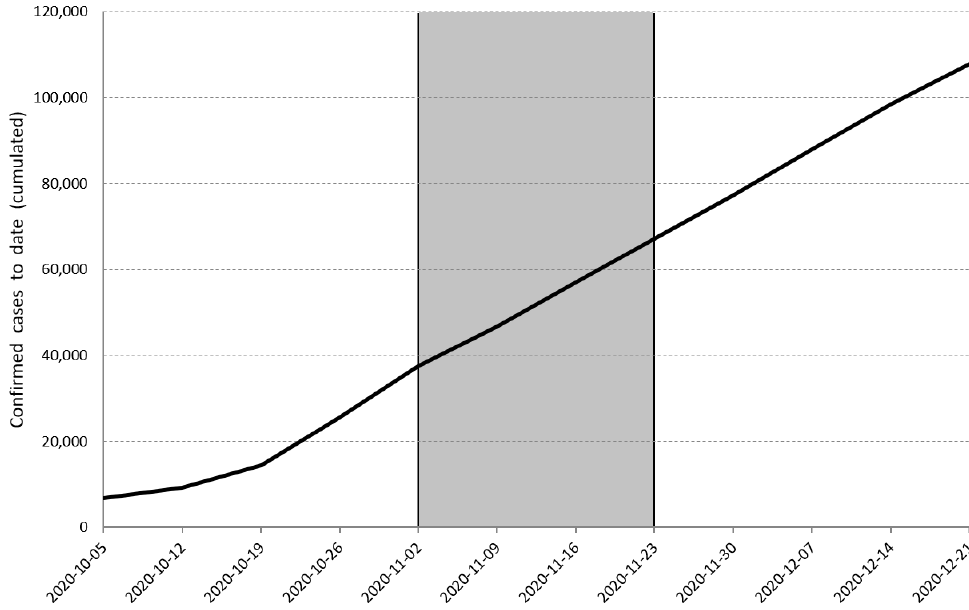
Figure 1. Confirmed cumulative cases of COVID-19 in Slovenia from March 2020 to May 2021. Note: Grey area marks the timing and duration of the survey.